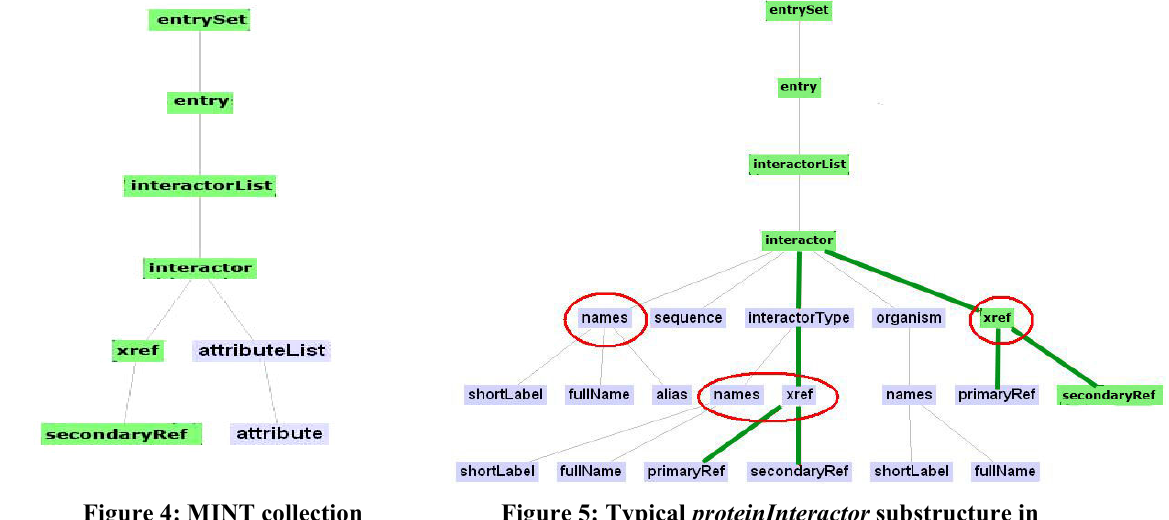
Figure 4: MINT collection at 10% coverage